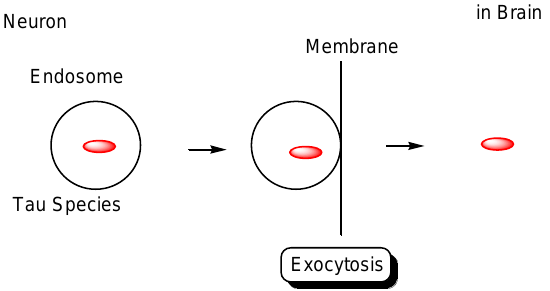
Figure 8. Tau in ectosomes (50 – 1000 nm in diameter) secreted from the membrane of neurons, in- dependently on the endolysosomal machinery.